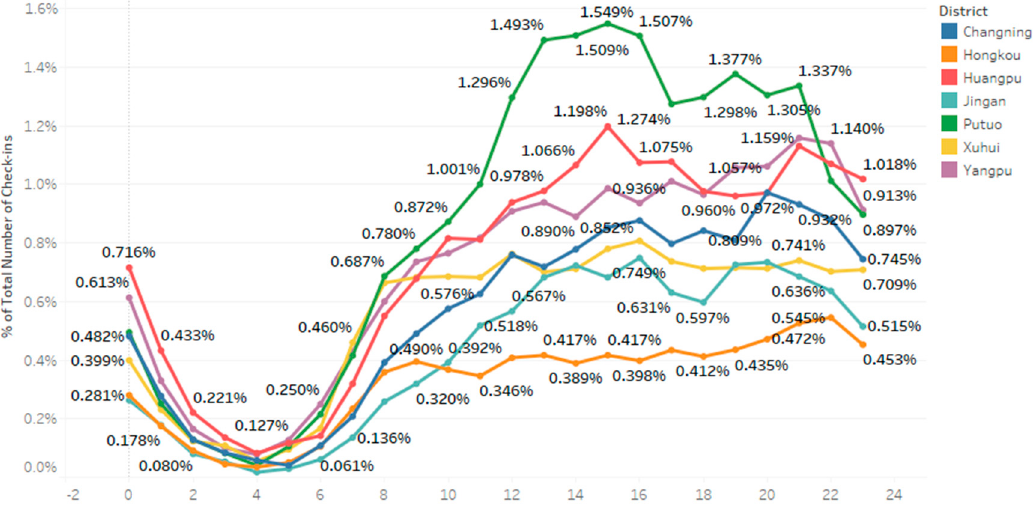
Figure 9. Absolute numbers per hour.